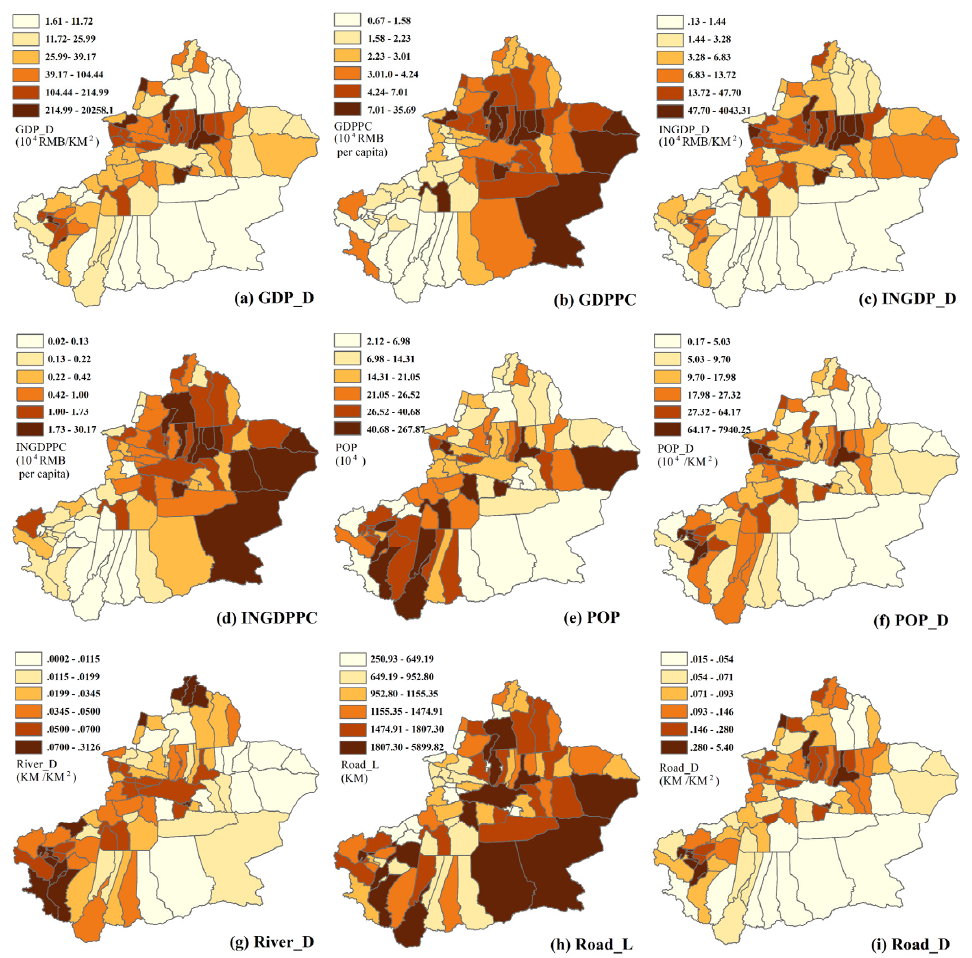
Figure 8. Spatial distributions of socio-economic factors. ( a ) GDP density (GDP_D), ( b ) GDP per capita (GDPPC), ( c ) industrial GDP density (INGDP_D), ( d ) industrial GDP per capita (INGDPPC), ( e ) population (POP), ( f ) population density (POP_D), ( g ) river density (River_D), ( h ) road length (Road_L), ( i ) road density (Road_D). All factors are discretized from continuous variables to categorical variables by quantile